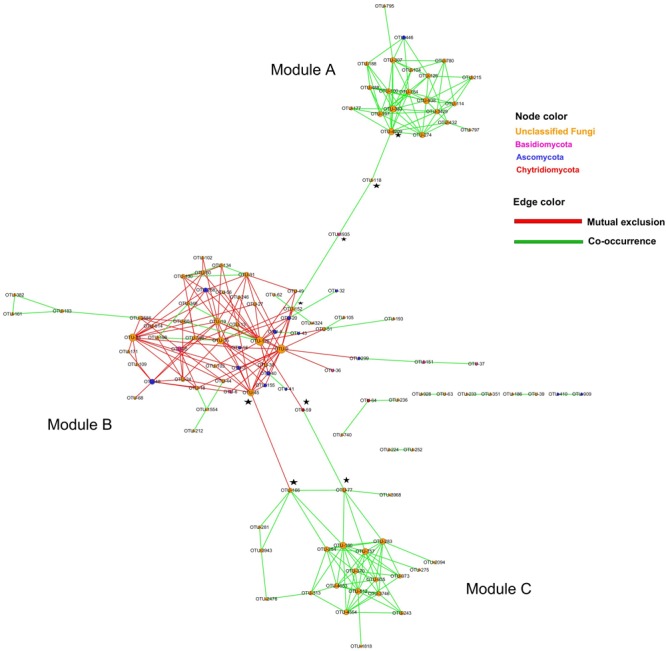
Planktonic fungi network showing significant co-occurrence and mutual exclusion relationships among abundance of clades in the Qinhuangdao coastal waters. Circles indicate OTUs; circle width is a function of the degree of node. The keystone OTUs are indicated by a five pointed star in black.